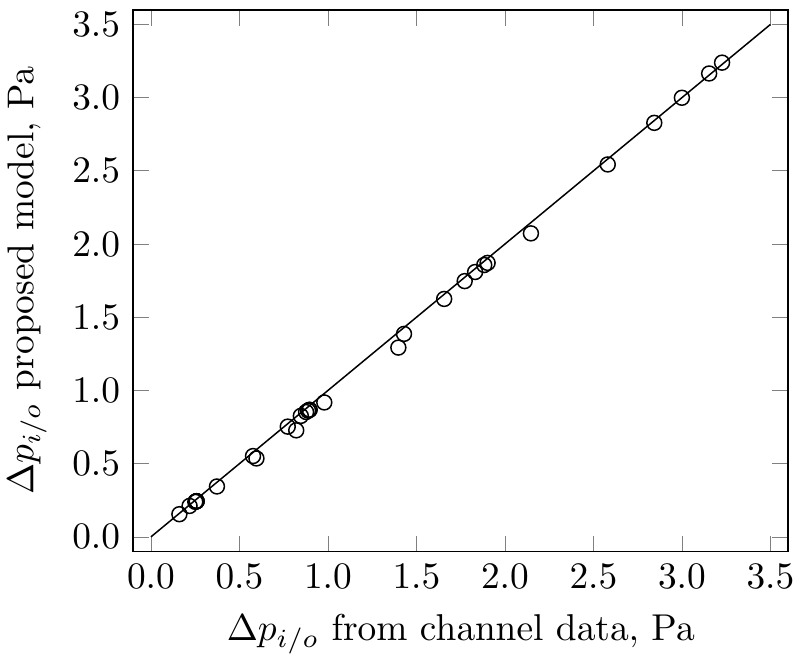
Figure 8. Comparison of ∆ p i / o measured from the discrete channel and predicted from the pro- posed